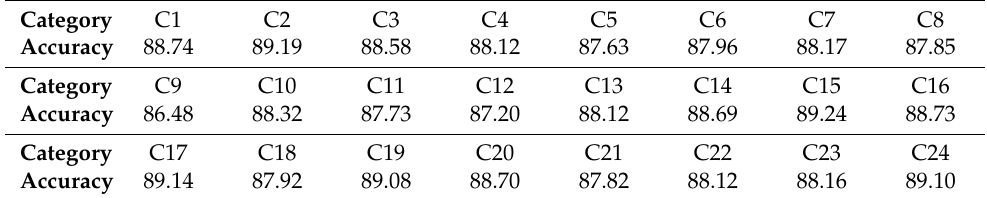
Table 3. Best accuracy % of 24 sentiment analysis (SA)